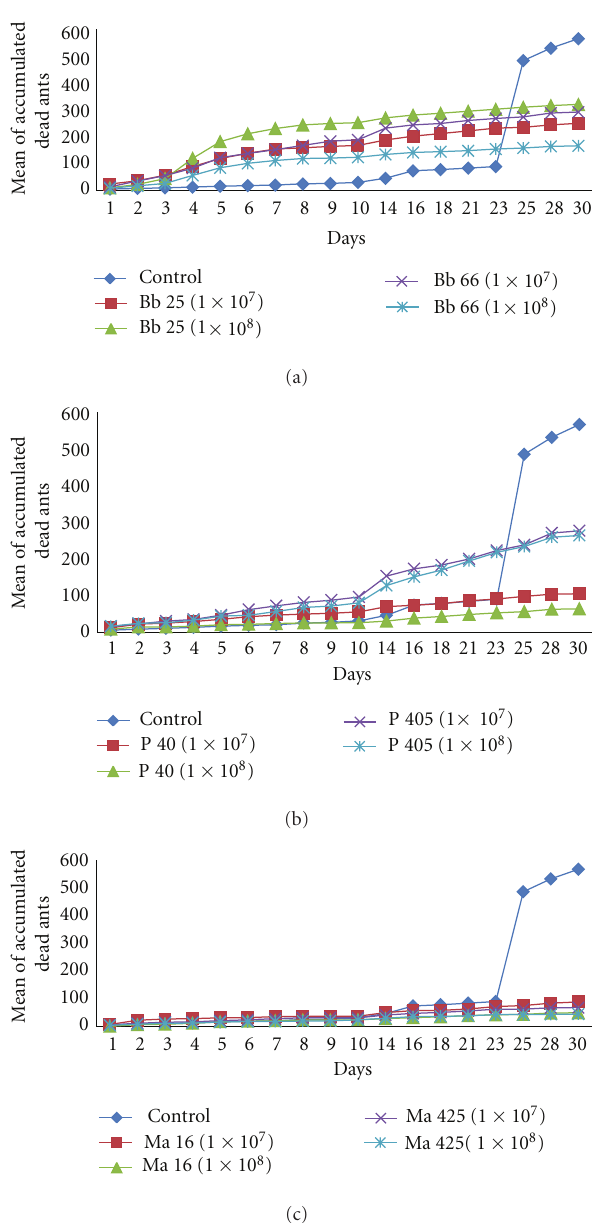
numbers than those of the control colonies, but fungal growth on cadavers was no longer